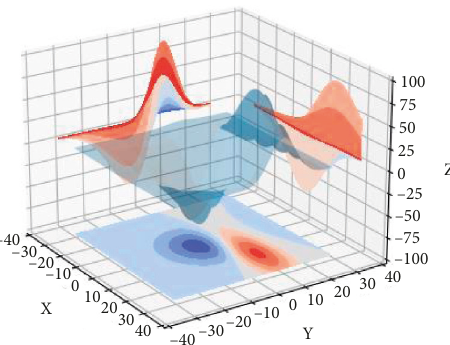
Figure 9: Semantic complexity relationship diagram.